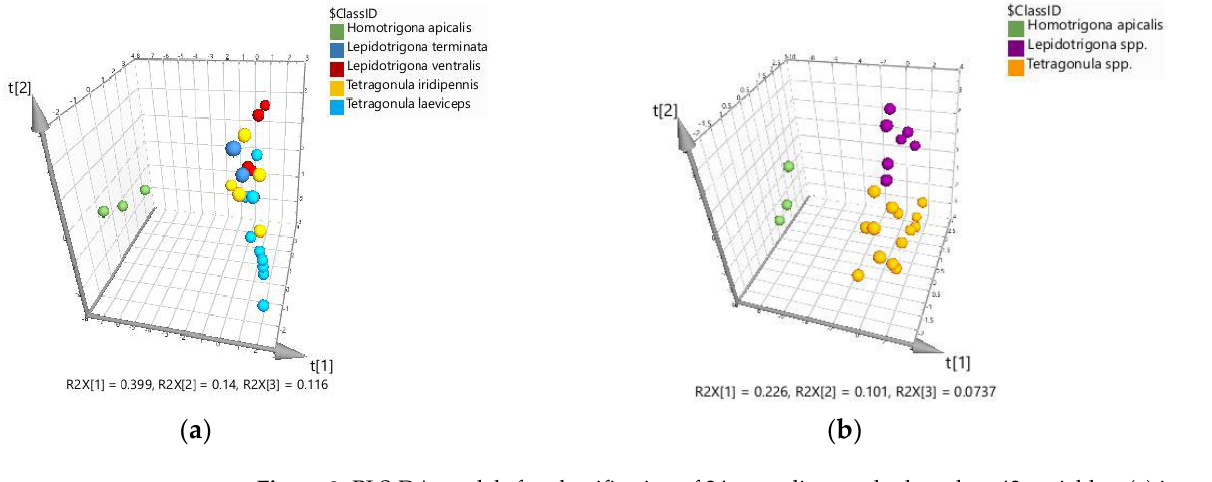
Figure 2. PLS-DA models for classification of 24 propolis samples based on 43 variables: ( a ) in accordance with five bee species ( Tetragonula iridipennis —5 samples; T. laeviceps —9 samples; Lepidotrigona ventralis —5 samples; L. terminata —2 samples; Homotrigona apicalis —3 samples); ( b ) in accordance with three genera, Tetragonula, Lepidotrigona and Homotrigona .